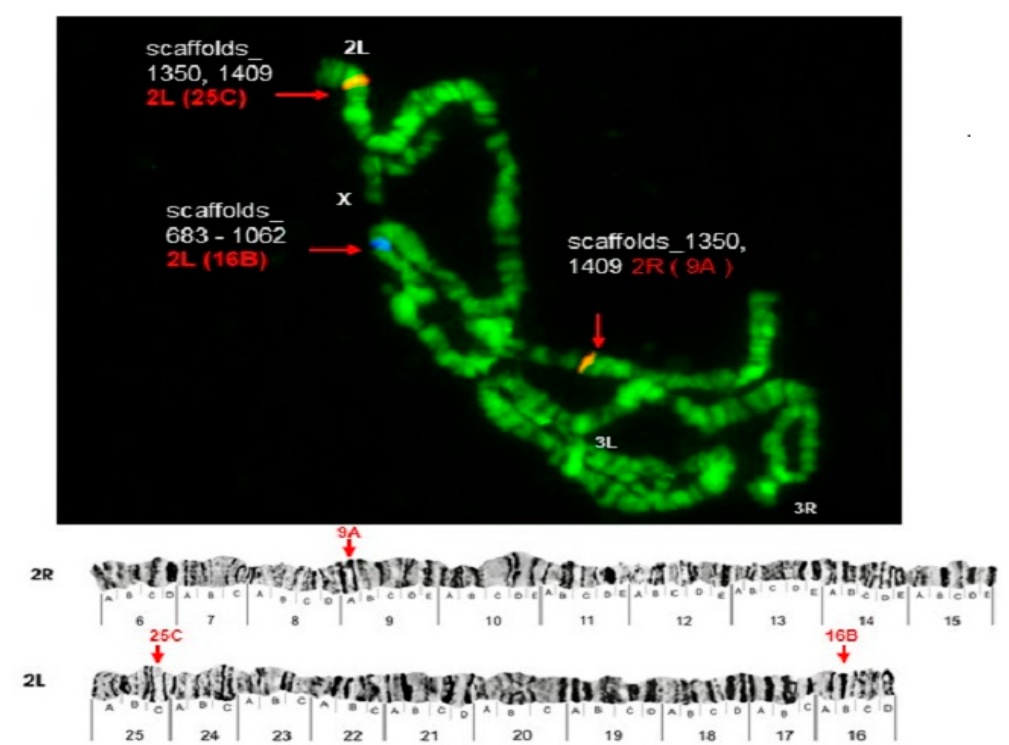
Figure 4. Pb17r-Cy 3 hybridized in situ on 2R (9A) and 2L (25C), and Pb18b-Cy 5 probe, mapped in 2L (region 16B). Chromosomal bands with positive hybridization are identified with text in red, and the corresponding scaffolds in An. darlingi genome assembly AdarC3 are indicated in white text.